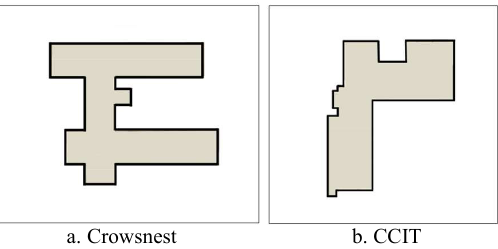
Figure 5. 2D floor maps of the experiment